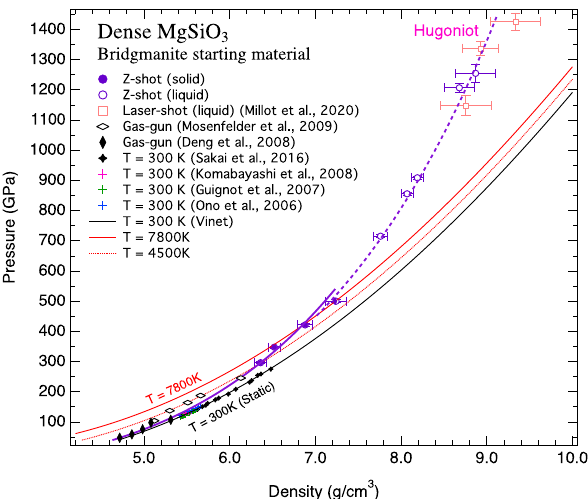
Fig. 1 Hugoniot data obtained using dense MgSiO 3 -bridgmanite as the starting material. The pressure – density data from magnetically driven shock wave experiments in this study are shown with the purple circles. The orange open squares represent liquid MgSiO 3 Hugoniot data by the laser-driven shock 18 . The black solid and open diamonds represent compression data by the gas-gun method 9,10 . The static compression data for MgSiO 3 post-perovskite at 300 K 3 – 6 are also shown for comparison. The purple solid and dashed curves are the calculated Hugoniots for post- perovskite and liquid, respectively, by DFTMD simulations. The calculated isotherms at 300, 4500, and 7800 K are shown with solid black, dashed red, and solid red curves,